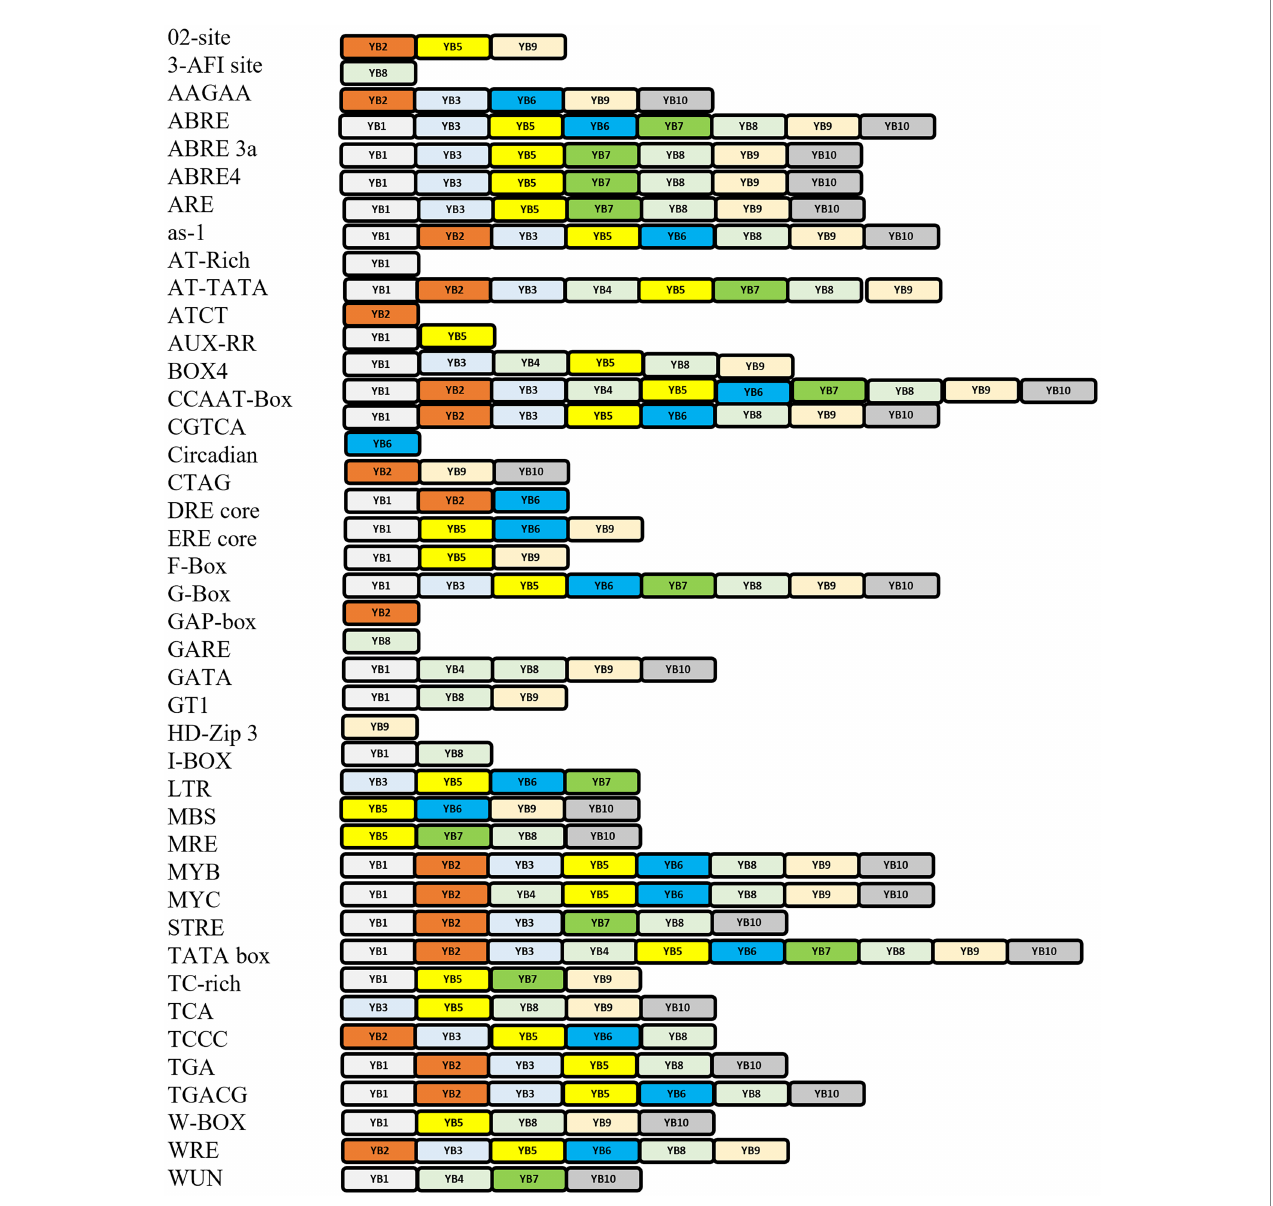
FIGURE 4 Representation of cis -elements typically occurring in the promoters of the AtNF-YB family of TFs. Cis -regulatory elements (CREs) are on the left along with corresponding colour coded AtNF-YB